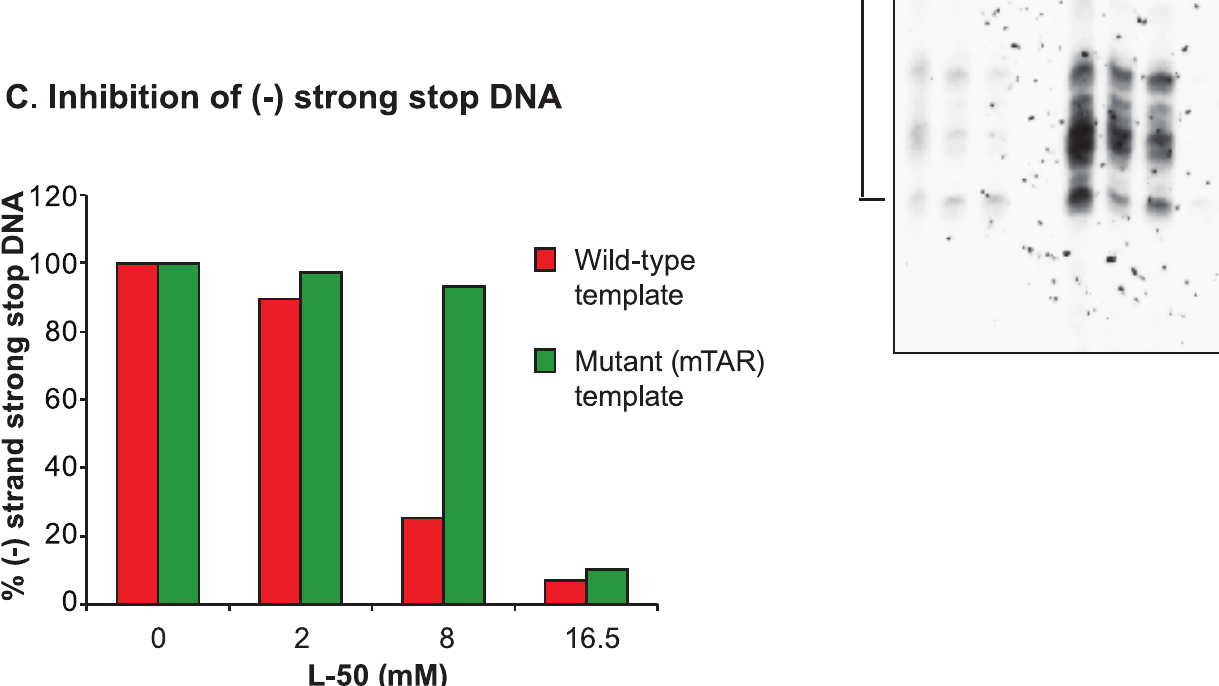
Figure 9. Minus strand strong stop DNA synthesis from wild type or mutant. ( A ) Schematic representation of HIV-1 RNA fragments representing the R, U5, and primer binding sequence (PBS) in wild type (wt_R_u5_pbs), site-directed mutagenesis of the TAR bulge (mutant TAR), or